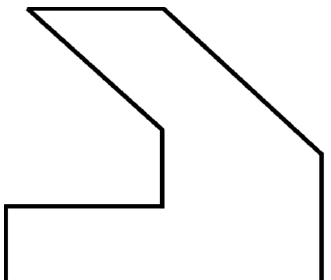
Figure 19. Concave polygonal area.